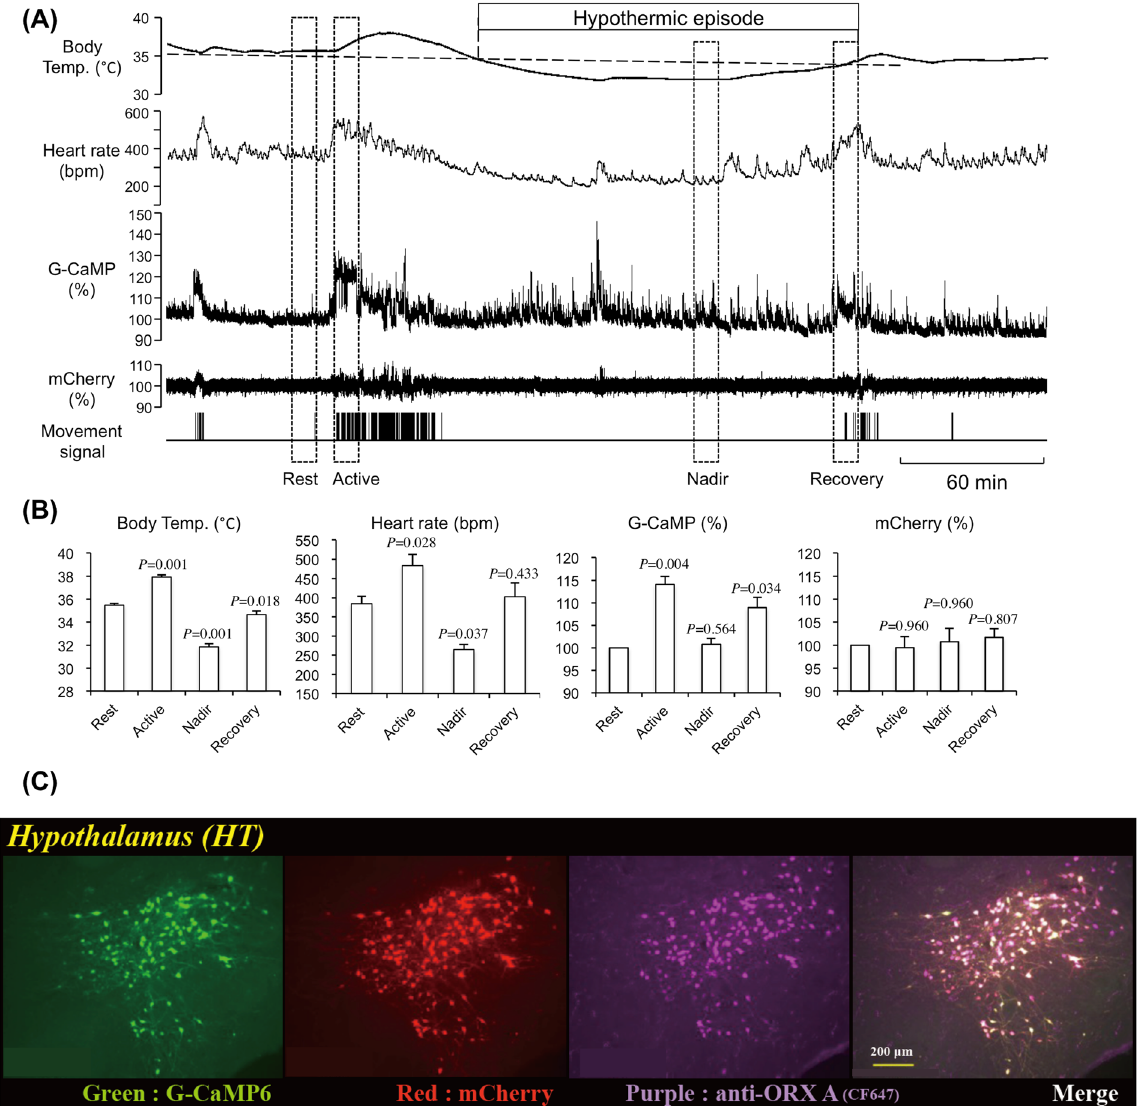
Figure 2. Activity recording of orexin neurons using fiber photometry during fasting-induced hypothermia. ( A ) Representative traces of body temperature, heart rate, G-CaMP fluorescence, mCherry fluorescence, and body movement in a mouse expressing G-CaMP and mCherry exclusively in orexin neurons. The first hypothermic episode during the fasting period is shown. ( B ) Averaged body temperature, heart rate, G-CaMP fluorescence, and mCherry fluorescence during four typical periods indicated by the dashed rectangles (10 min length) shown in A. See text for the definitions of Rest, Active, Nadir, and Recovery. Fluorescence intensity during the rest period was defined as 100%. ( C ) Histological evidence showing that G-CaMP and mCherry were exclusively expressed in almost all orexin neurons. In ( B ), data are presented as mean ± SEM of 5 animals. Data were collected only for the 1st hypothermic episode even if the animal experienced multiple hypothermic episodes. P values were calculated using the Holm-Sidak multiple comparison